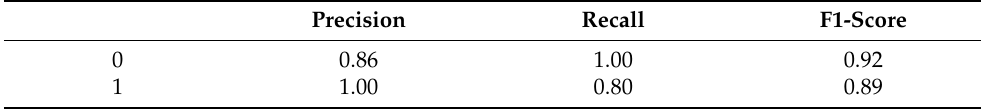
Table 1. Performance Metrics for Testing Data.